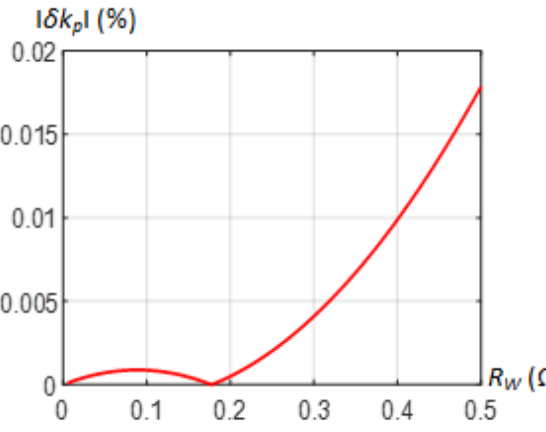
Figure 7. Error dependence on the load resistance 𝑅 𝑙 .